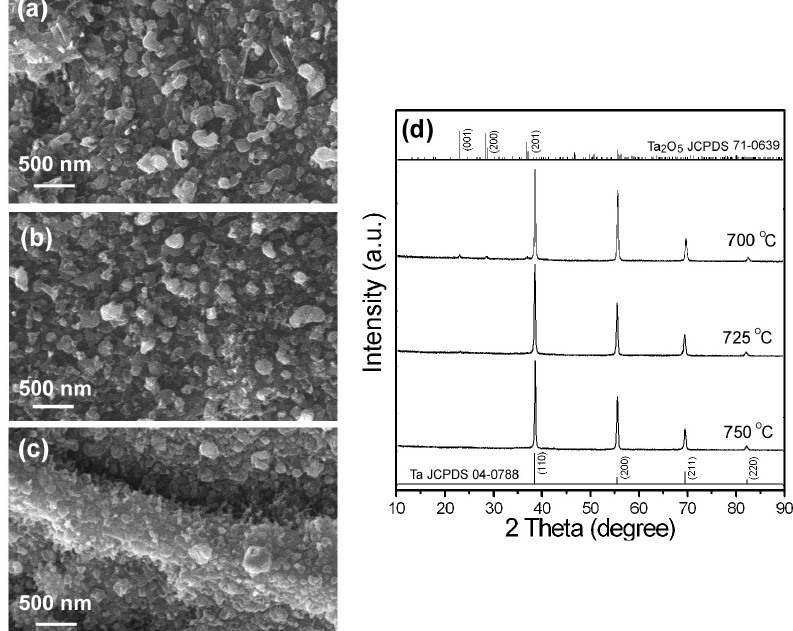
Figure 2. ( a – c ) The top-view SEM images and ( d ) the corresponding XRD spectra of the oxidative Ta samples after CVD growth using a catalyst of Ni1Au1 with the substrate temperatures of ( a ) 700 °C, ( b ) 725 °C, and ( c ) 750